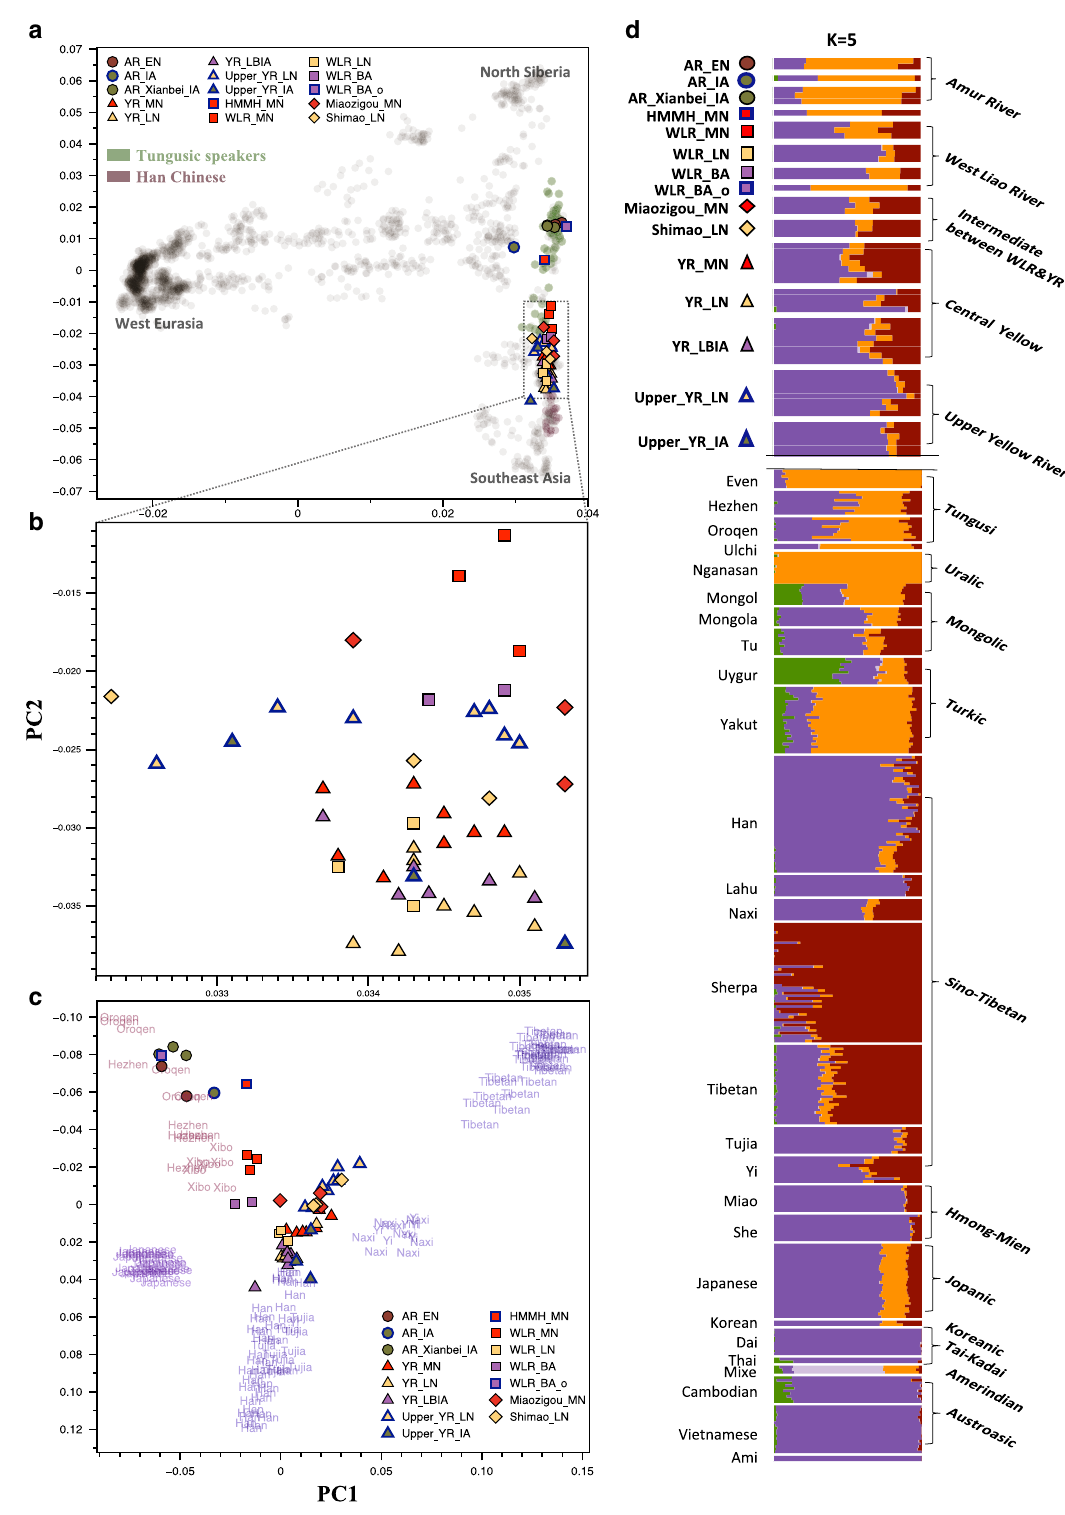
Fig. 2 A summary of the genetic pro fi les of the ancient and present-day East Asian populations. a The fi rst two principal components constructed from 2077 present-day Eurasians; the ancient individuals are projected onto the fi rst two PCs. Color- fi lled shapes represent ancient individuals, with the color- shape combinations as used in Fig. 1. Opaque circles represent the present-day individuals used for calculating PCs. Tungusic-speaking populations and Han Chinese are marked by green and purple shades, respectively. Individuals from other populations are marked by gray shades. The population labels of present-day individuals are provided in Supplementary Fig. 4. b A zoom-in visualization of the WLR and YR clusters in a . c The fi rst two principal components calculated from present-day individuals from nine East Asian populations in the “ 1240k-Illumina ” dataset. Present-day individuals are marked by their corresponding population names. d ADMIXTURE results for the “ 1240k-Illumina ” dataset at K = 5. Only the East Asian populations are plotted. Present-day populations are sorted and colored according to their linguistic